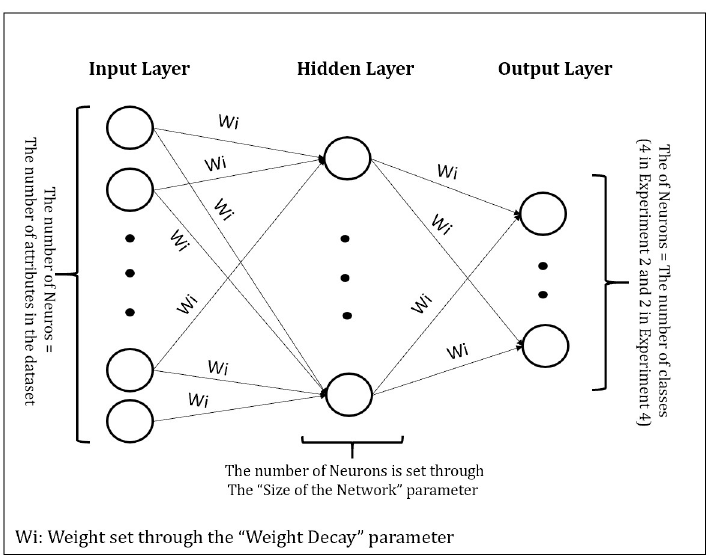
Fig 3. The architecture of the Neural Network